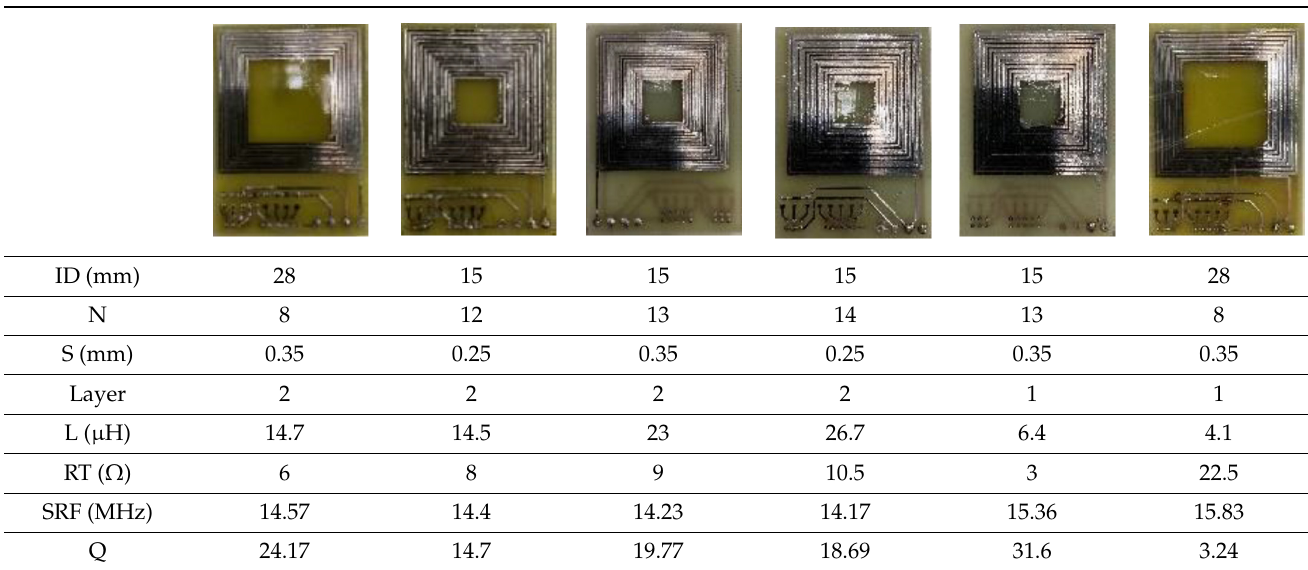
Table 1. Specifications of fabricated coils (OD is 50 mm, W is 1 mm, and C tank is fixed to 680 pF).